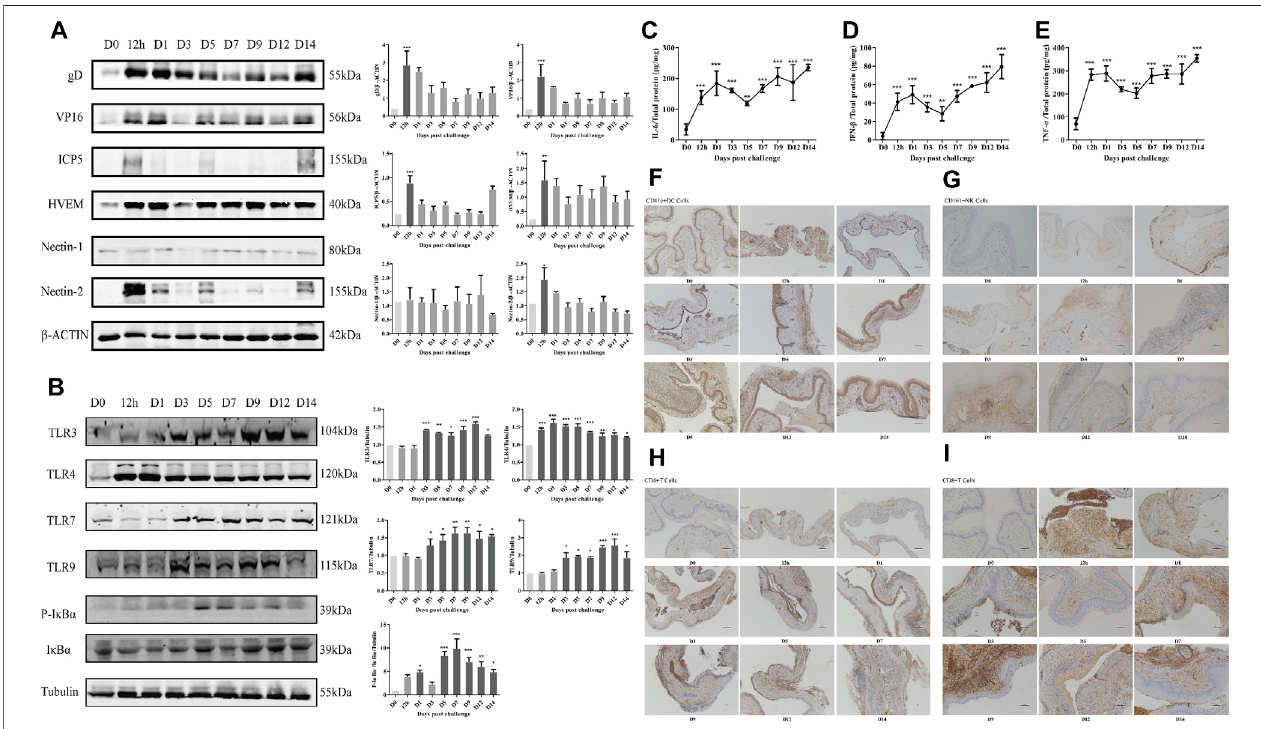
FIGURE 4 | Changes of experimental indexes in vaginal tissue at different time points after modeling in GH mice. The expression of membrane fusion-related proteins (A) ,TLRsignalingpathway-relatedproteins (B) ,IL-6 (C) ,IFN- β (D) ,TNF- α (E) ,andthein fi ltrationofCD11c+DC (F) ,CD161+NK (G) ,CD4+T (H) ,CD8+T (I) cells over time within 2 weeks after modeling were measured. *p ＜ 0.05, **p ＜ 0.01, ***p ＜ 0.001 vs. D0